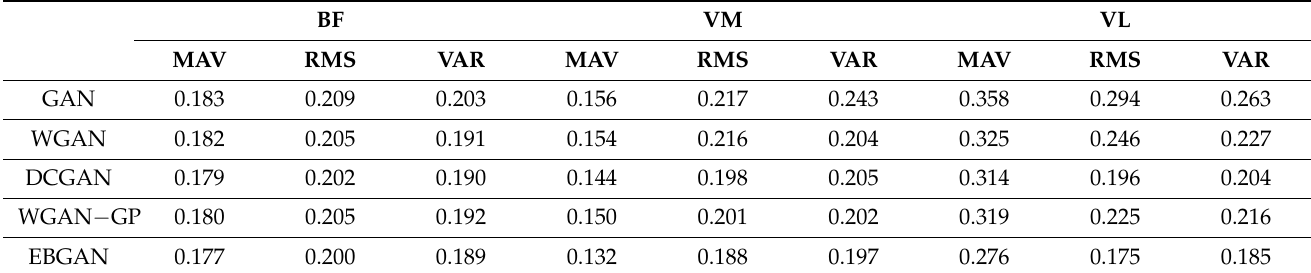
Table 3. MMD values of various data generation methods.